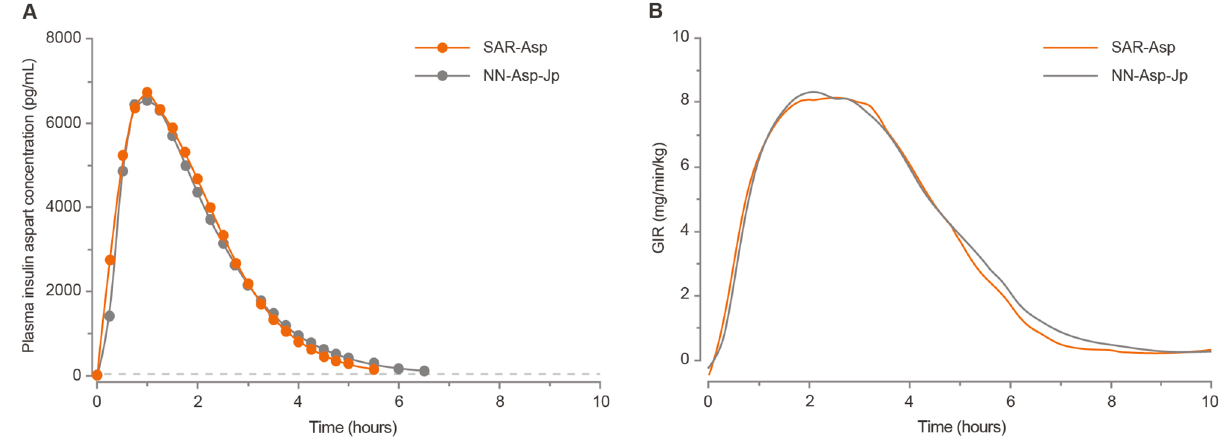
Figure 1. Linear arithmetic mean insulin aspart plasma time profiles ( A ), mean smoothed LOESS fits of body weight standardized GIR versus time profiles (GIR values less than 0 at baseline are results of the LOESS smoothing) ( B ). The horizontal line in ( A ) is the lower level of quantification (100 pg/mL). GIR glucose infusion rate, LOESS locally weighted scatterplot smoothing.